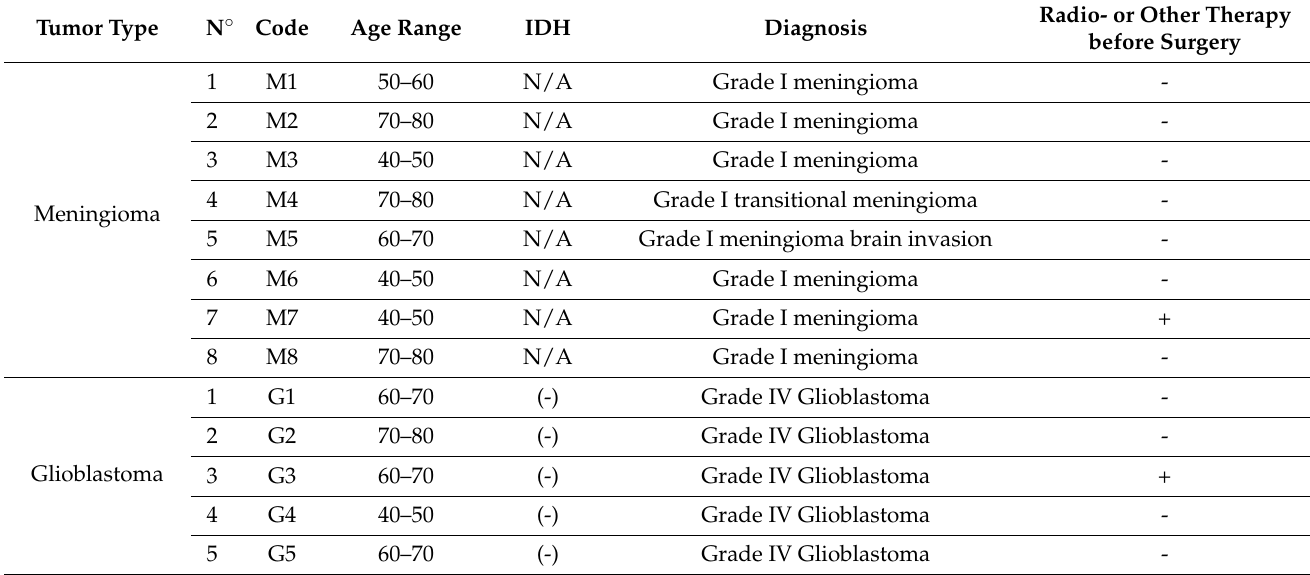
Table 1. Summary of patient data—tumor type, age range, diagnosis and therapy preceding surgery (N/A = not applicable; (-) =